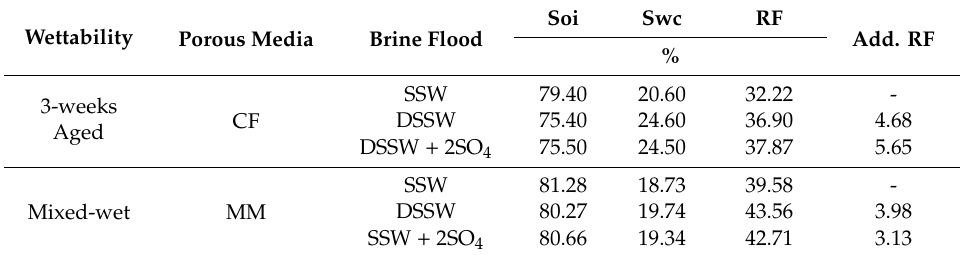
Figure 11. Oil recovery factors of secondary mode brines flood through oil-wet core plugs and micromodels. MM represents the oil recovery from micromodel, CF represents the oil recovery from core flood. Diff.CF/ Diff.MM describes the difference in the RF of the brine flood minus the RF through SSW injection. Table 6. Complex-wet cores and micromodels with initial fluids saturations and oil recoveries in secondary mode brines flood.